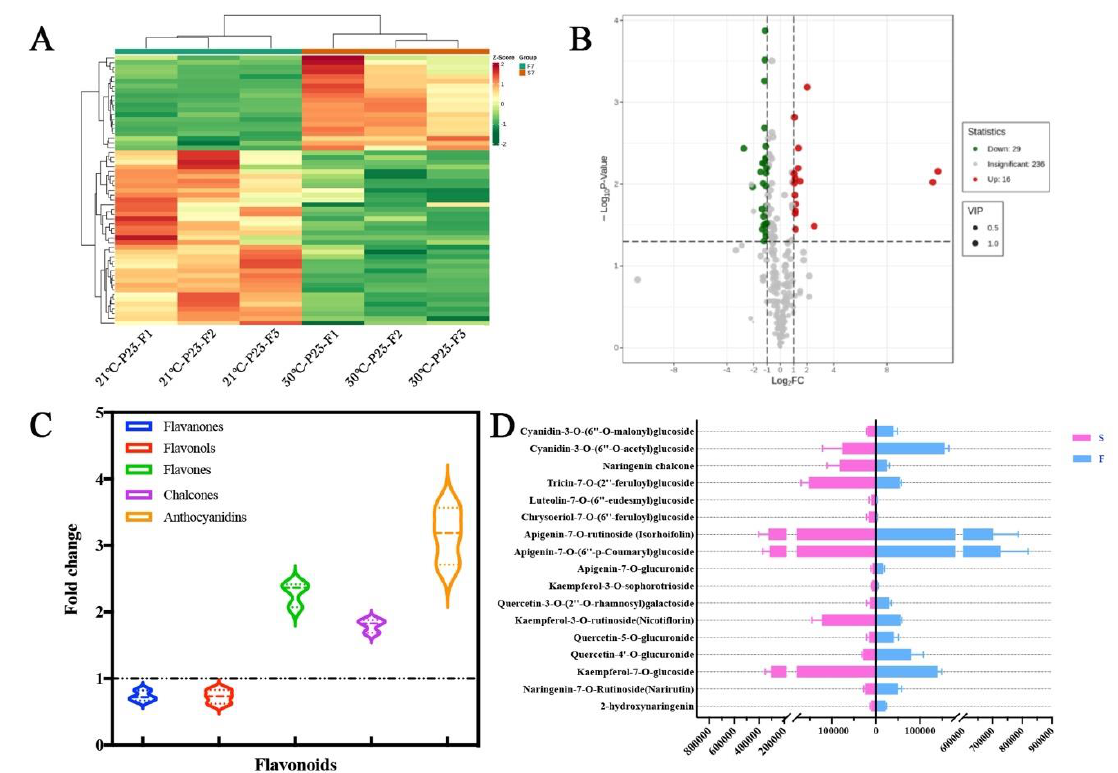
Figure 7. Analysis of flavonoid metabolites in anthers of fertility differential plants. ( A ) Cluster heatmap of differential metabolites. ( B ) Volcano Plots of differential metabolites. ( C ) Ratio of total class II flavonoid metabolites in fertile to sterile anthers. ( D ) Relative contents of different class II flavonoid metabolites in fertile and sterile anthers.